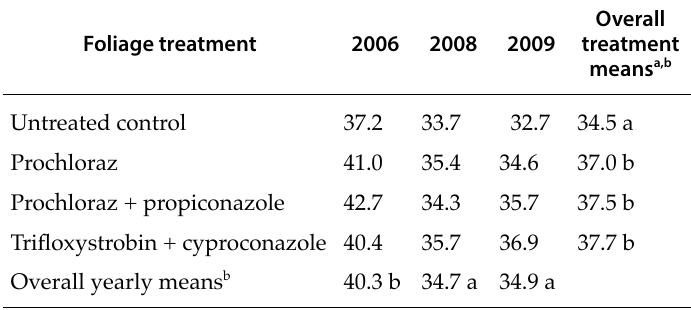
Table 6. Mean thousand grain weights (g) from wheat plots treated with different fungicides during three growing seasons. Foliage